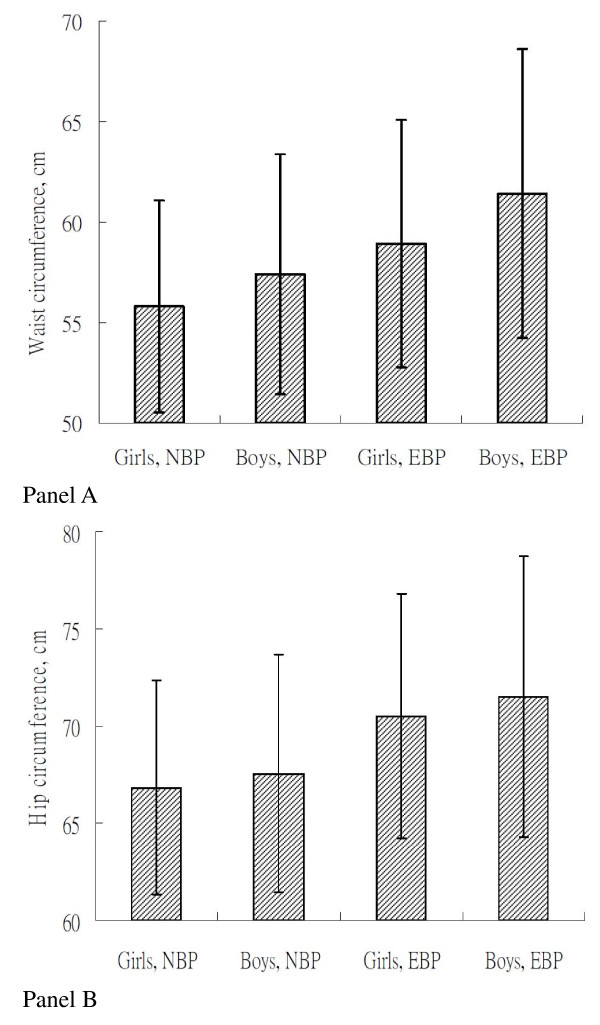
Means of waist circumference and hip circumference by sex and status of elevated blood pressure. (NBP, normal blood pressure; EBP, elevated blood pressure); P < 0.0001 among four groups in both panels.